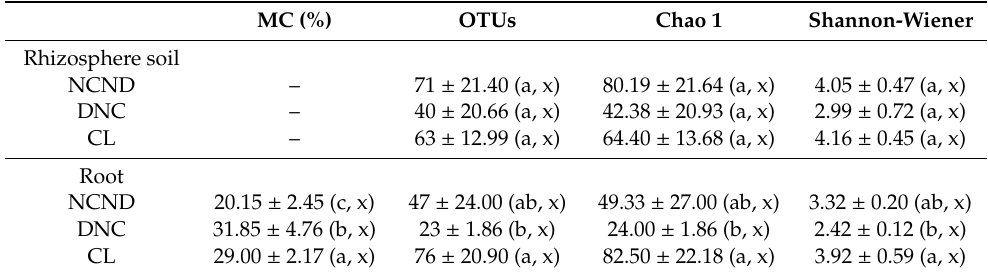
Table 2. Mycorrhizal colonization and diversity of arbuscular mycorrhizal fungi (AMF) taxa in the rhizosphere soil and root of C. dactylon grown in three contrasting land types along the drawdown zone of Three Gorges Reservoir.